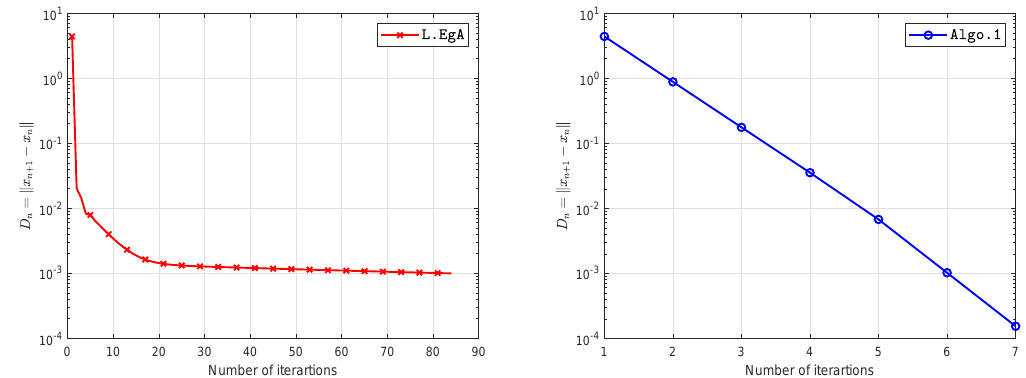
Figure 7. Example 2 for average number of iterations while n =